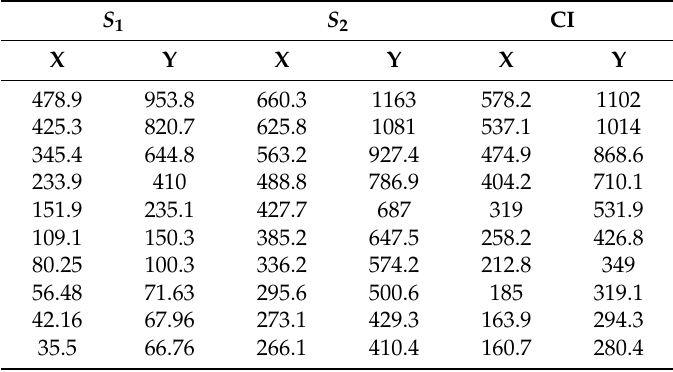
Figure 12. Comparison of RMSE in Y axis between the proposed Gaussian mixtures (GM) fusion, local IMM and CI. Table 1. Comparison of RMSE (m) in X and Y axis (64 s–120 s).